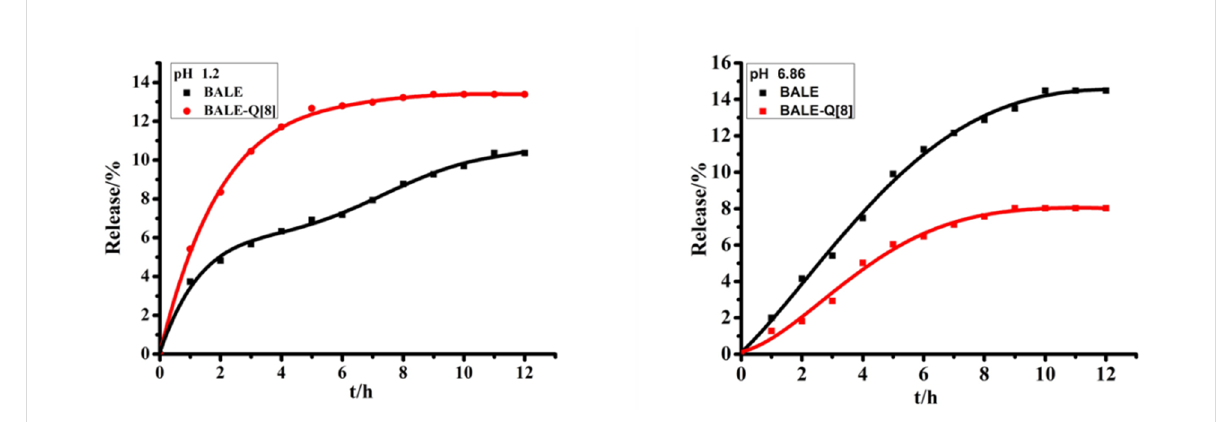
Figure 10: The release curves of BALE and